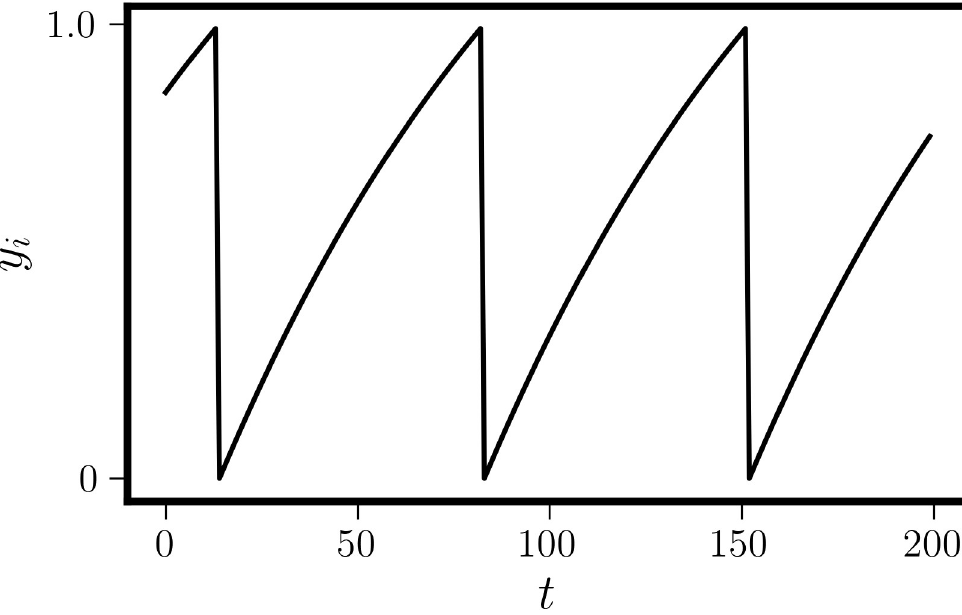
Fig 1. Nodal intrinsic dynamics. The first 200 time-steps of Eq 1. The node spikes when the activity crosses a threshold of 1, and then resets to a baseline of 0.